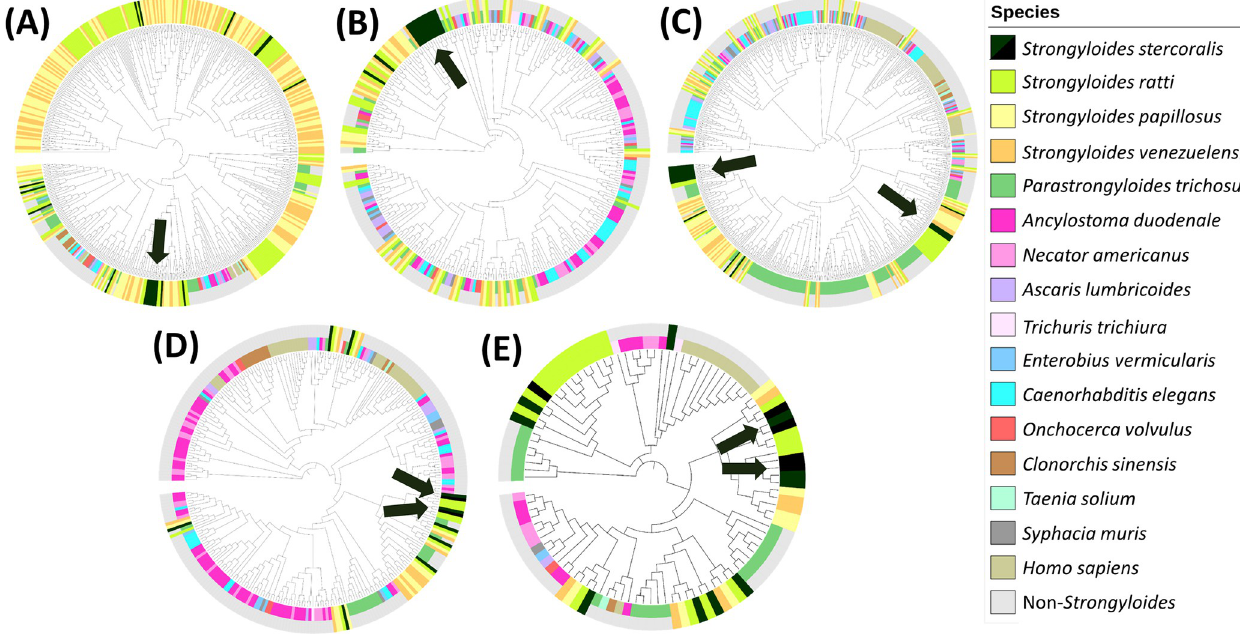
Fig 4. Phylogenetic alignment of Strongyloides stercoralis high priority family proteins with other S . stercoralis proteins and outgroups. Proteins of the five priority families of S . stercoralis (dark green), from the differentially expressed dataset, in phylogenetic alignment with BLAST hits from S . stercoralis itself (black) and outgroups (other colours). Colours reaching the outer edge represent Strongyloides species, whereas shorter colour bands are non- Strongyloides outgroups. (A) SCP/TAPS, (B) transthyretin-like (TTL), (C) acetylcholinesterase (AChE), (D) aspartic peptidase, (E) prolyl oligopeptidase (POP). Arrows indicate clusters of S . stercoralis proteins containing species-specific regions; derived from both gut- and non-gut-dwelling differential expression data, augmenting detection of lack of species specificity. These results originate from methods in Fig 1, box K.